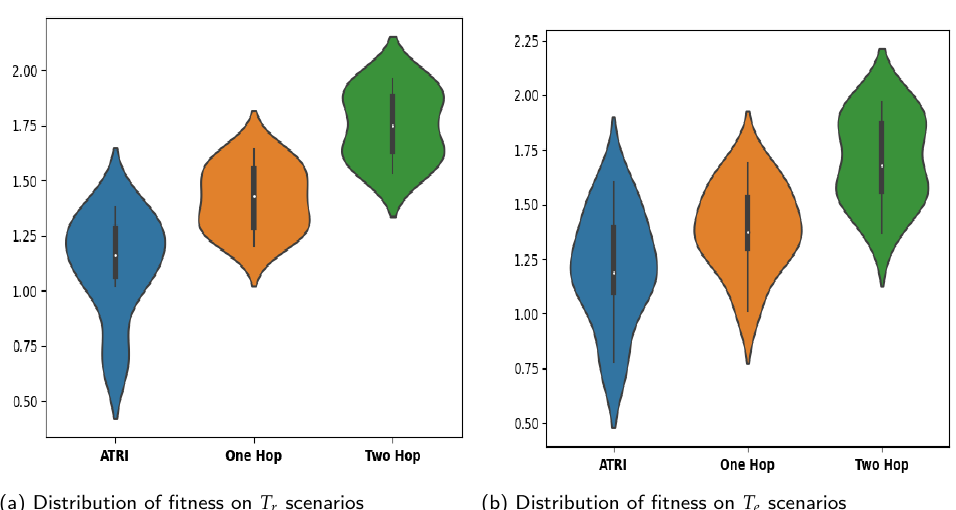
Figure 11. ( a , b ) show the distribution of fitness for each unique pair of UAVs and users on 4 training and 100 testing scenarios, respectively. In each case, Best 2 h better indicates better transferability of evolved